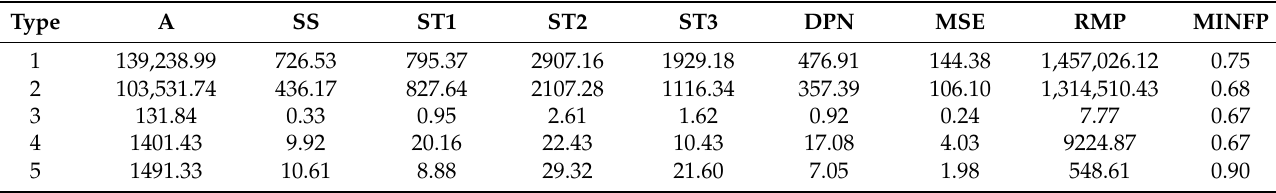
Table 3. Electricity characteristics in